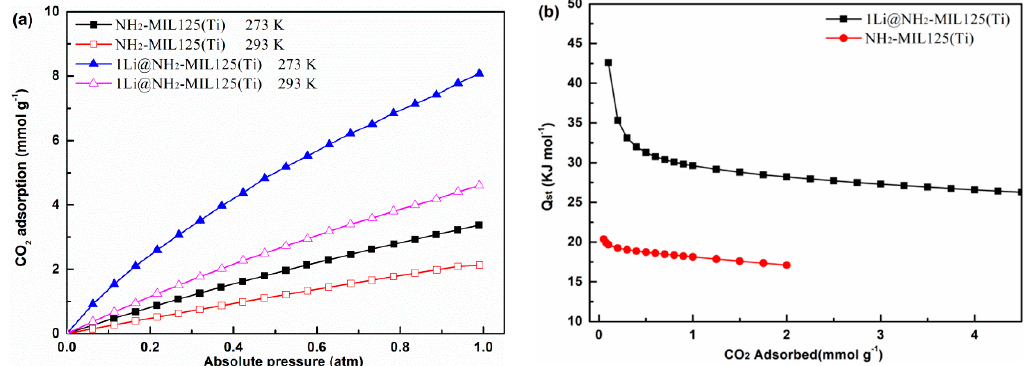
Figure 10. ( a ) The CO 2 adsorption isotherms at 273 and 293 K. ( b ) The heats of CO 2 adsorption